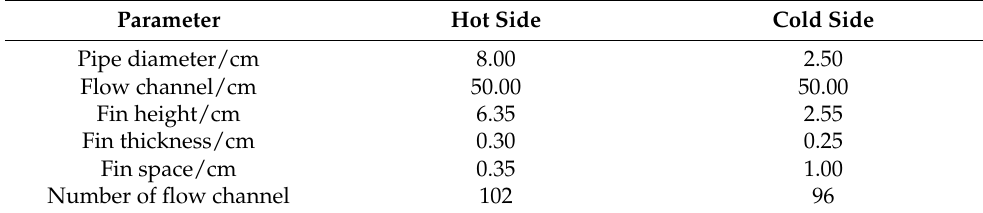
Table 1. The experimental plate fin evaporator parameters.